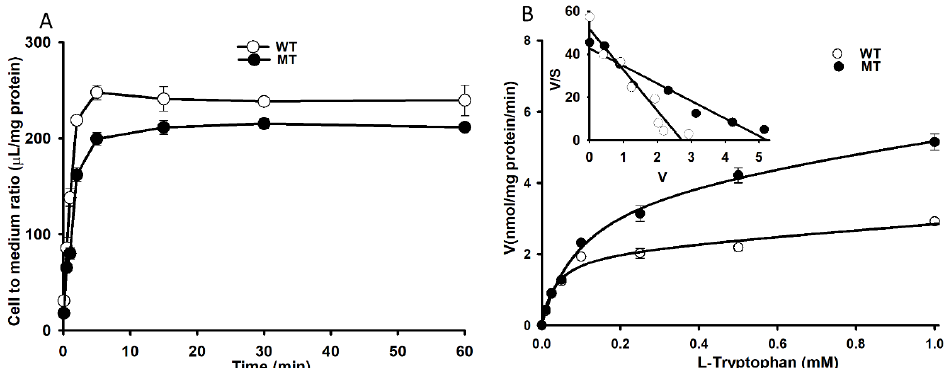
Figure 5. Time and concentration dependency of [ 3 H] L -tryptophan uptake by NSC-34 cell lines for 5 min at pH 7.4 ( A ) Time dependent uptake was evaluated between 5 s to 60 min. ( B ) Concentration dependency was evaluated for 5 min in the presence of unlabeled L -tryptophan (0–1 mM). The embedded graph shows the Scatchard plot in NSC-34 cell lines. ( ) represents NSC-34 wild type cell lines (WT, NSC-34 hSOD1 WT ); ( • ) represents NSC-34 mutant type (MT, NSC-34 (cid:35) hSOD1 G93A ) cell lines. Each point represents the mean ± SEM ( n =